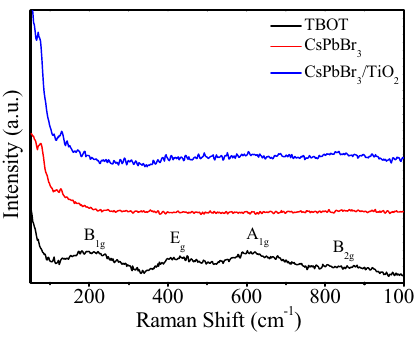
Fig. 7 Raman spectra acquired from TBOT, CsPbBr TiO nanocomposites 2